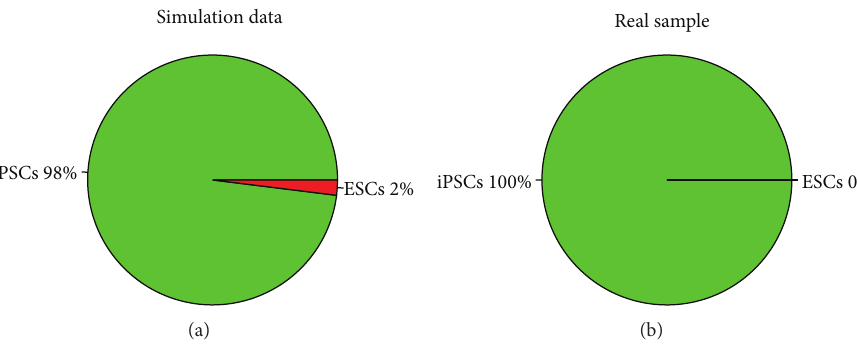
Figure 2: Cell type discrimination. Cell types are discriminated by estimating the probability of each type. Normally and always, the biomarkers for discriminating a pair of cell types (e.g., ESCs versus iPSCs) are used to discriminate cell types. After running the biomarkers from the start point to the end point, the probability of cell types will be summarized and a cell type will be assigned to the sample in basis of the higher probability. (a) A simulated sample with 98% probability of iPSCs and only 2% of ESCs, so the sample is discriminated as